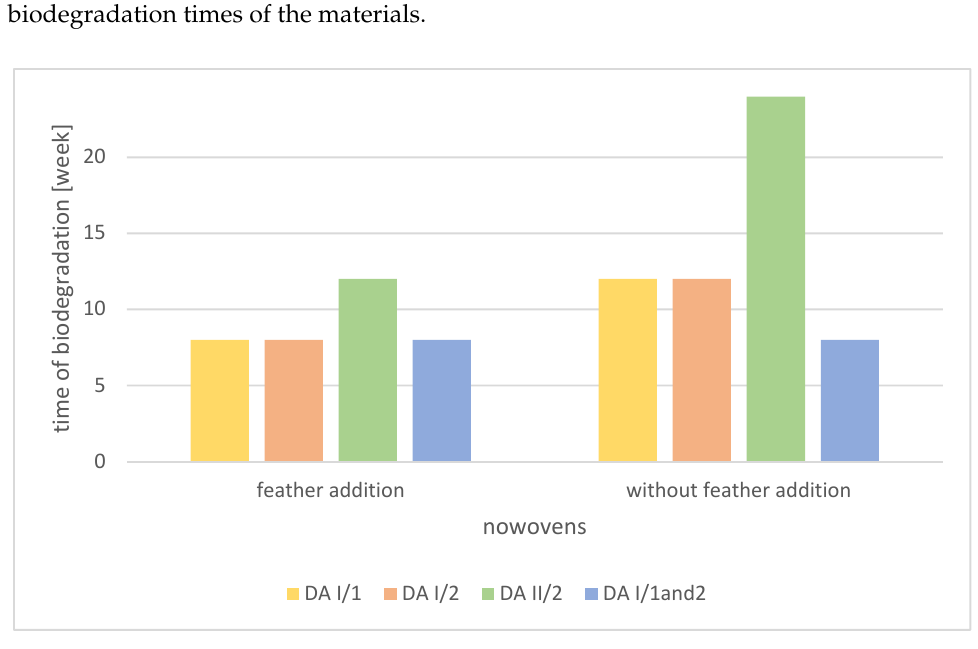
Figure 1. The biodegradation times of the samples, with and without the addition of feathers, for the samples in Group II.